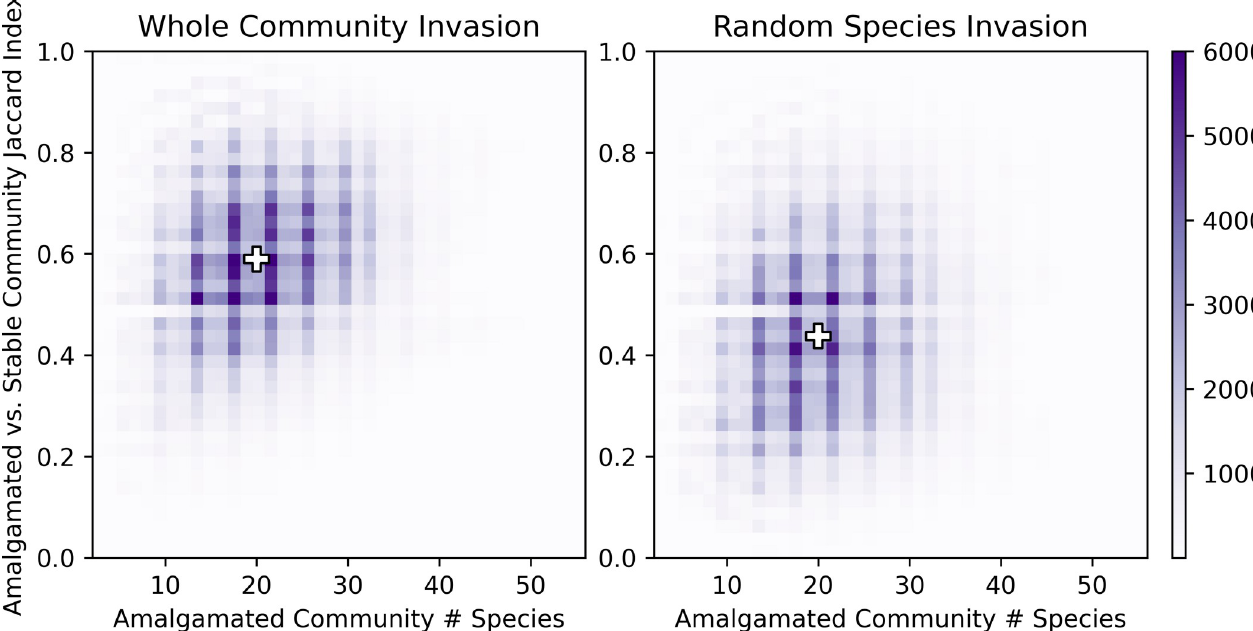
Fig 5. The Jaccard index vs. the total number of native and invasive species at the time of invasion. The “+” symbols indicate the medians. The Jaccard index tends to be greater when the invaders form a stable community (left) compared to when the invaders do not form a stable community (right), indicating that whole community invasions result in less species